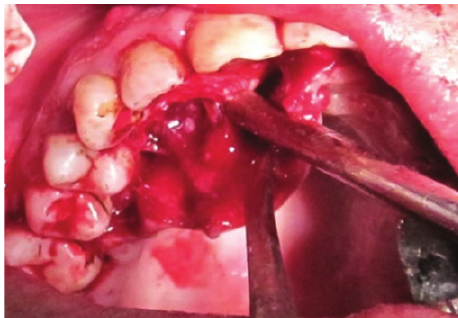
Figure 14: Splinting of mobile teeth using composite.